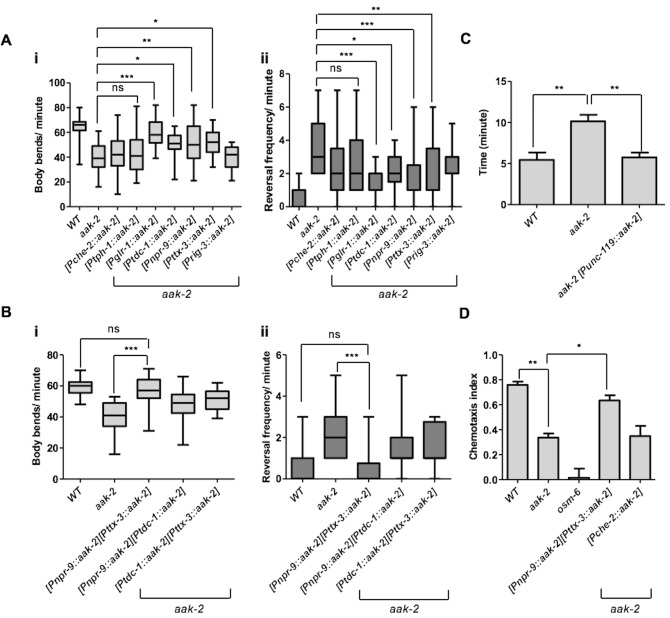
AMPK acts in the AIB and AIY interneurons to integrate chemosensory signals and trigger distal exploratory behaviour in starved animals.(A) Targeted expression of aak-2 within the GLR-1-expressing neurons [Pglr-1::aak-2], RIM neurons [Ptdc-1::aak-2], AIB interneurons [Pnpr-9::aak-2] and AIY interneurons [Pttx-3::aak-2], but not chemosensory neurons [Pche-2::aak-2], serotonergic neurons [Ptph-1::aak-2] or AVA neurons [Prig-3::aak-2] partially restores the distal exploratory defect in starved aak-2 mutants by affecting both forward locomotion (i) and reversal frequency (ii) (n>20), (one-way ANOVA *p<0.05, **p<0.001, ***p<0.0001). (B) Simultaneous rescue of aak-2 in the AIB and AIY using [Pnpr-9::aak-2][Pttx-3::aak-2] transgenes is sufficient to completely restore the defective exploratory behaviour typical of starved aak-2 mutants (n>20), (one-way ANOVA ***p<0.0001). (C) Starved worms were placed 1.5 cm away from a spot of food (fresh OP50) and the time required to encounter the food was monitored for the worms that found food within 16 minutes. aak-2 mutants display defective food detection indicated by increased time spent to find food and this defect can be rescued by specific expression of aak-2 throughout the nervous system using [Punc-119::aak-2] transgene (n>10). (D) Targeted expression of aak-2 within the AIB and AIY interneurons, but not the chemosensory neurons rescue the defective chemosensation of aak-2 mutants toward IAA (n>300). Error bars in (C,D) represent ± SEM (one-way ANOVA *p<0.05, **p<0.001).DOI:
http://dx.doi.org/10.7554/eLife.16349.00910.7554/eLife.16349.010Figure 2—source data 1.AMPK reconstitution in different neurons to restore the defective distal exploratory behaviour and defective chemotaxis typical of aak-2 mutants.